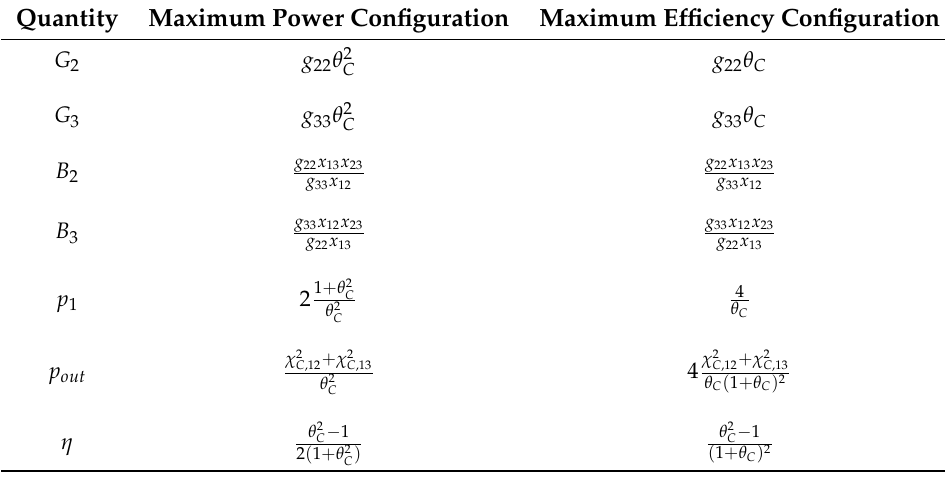
Table 1. Overview of the different quantities for the maximum power and the maximum efficiency solution.